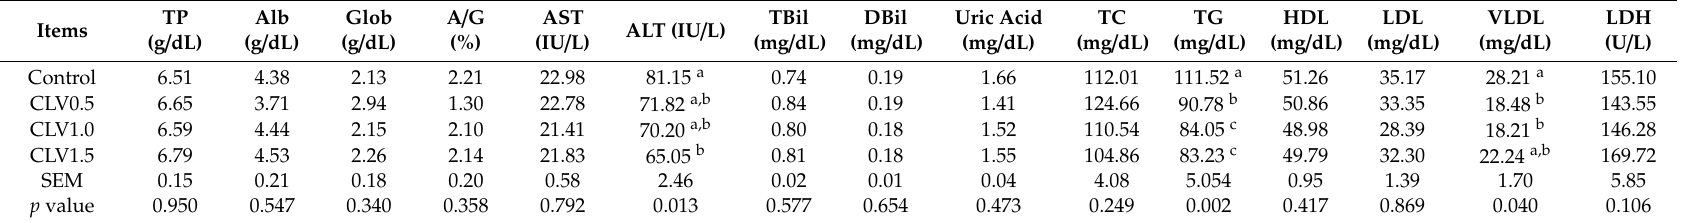
Table 6. Profiles of growing NZW rabbits as a ff ected by dietary treatments at 13 weeks of